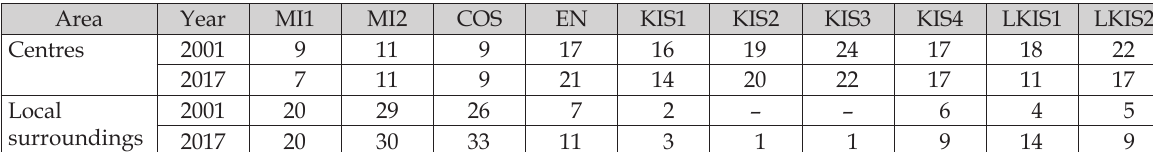
town.Table 5. No. of cases of specialisation (LQ>1) in 10 industries broken down by level of technological and knowledge intensity: centres and local surroundings (2001,